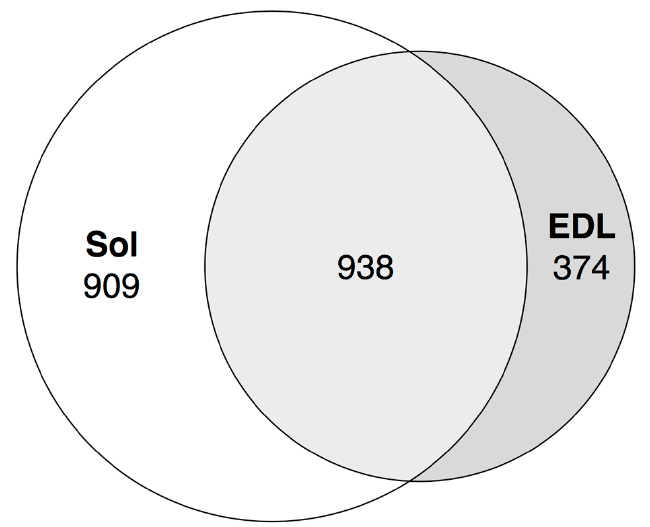
Figure 6. Tissue-specific enhancers of soleus and EDL muscles. Strandless coordinate intersection with 1 nt cutoff. See Supplementary Table ST11 for the full data.